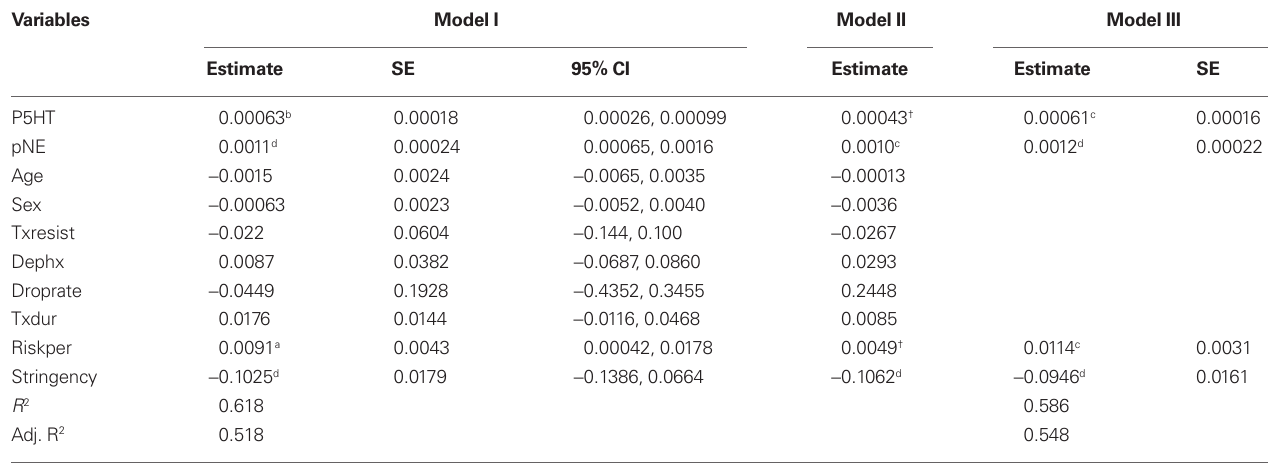
Table 5 | Parameter estimates and SE from the weighted least squares analyses (see